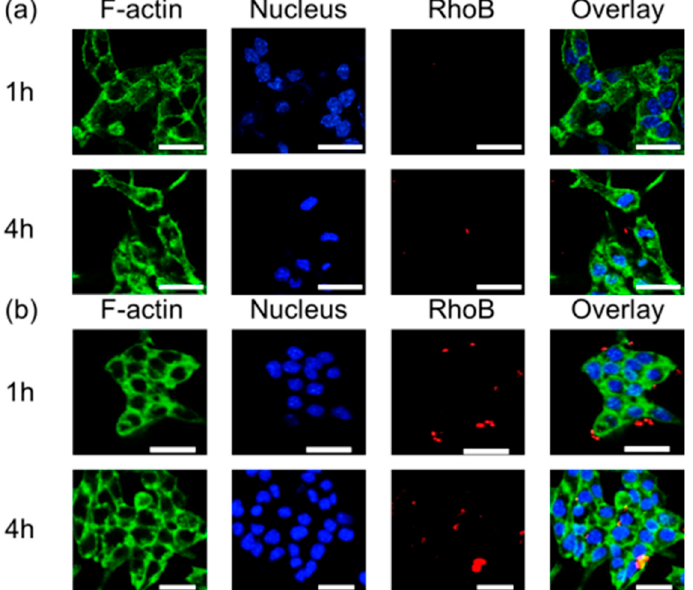
Figure 6. The cell association evaluation of ( a ) non-targeted RhoB-labeled AP3-AuNCs and ( b ) RhoB-labeled AP3-AuNCs-anti-PDL1 with 1 h and 4 h incubation using fluorescent staining. The f-actin, the nucleus of cells, and the RhoB-labeled AP3-AuNCs/RhoB-labeled AP3-AuNCs -anti-PDL1 were labeled as green, blue, and red colors, respectively (Scale bar = 10 μ m).